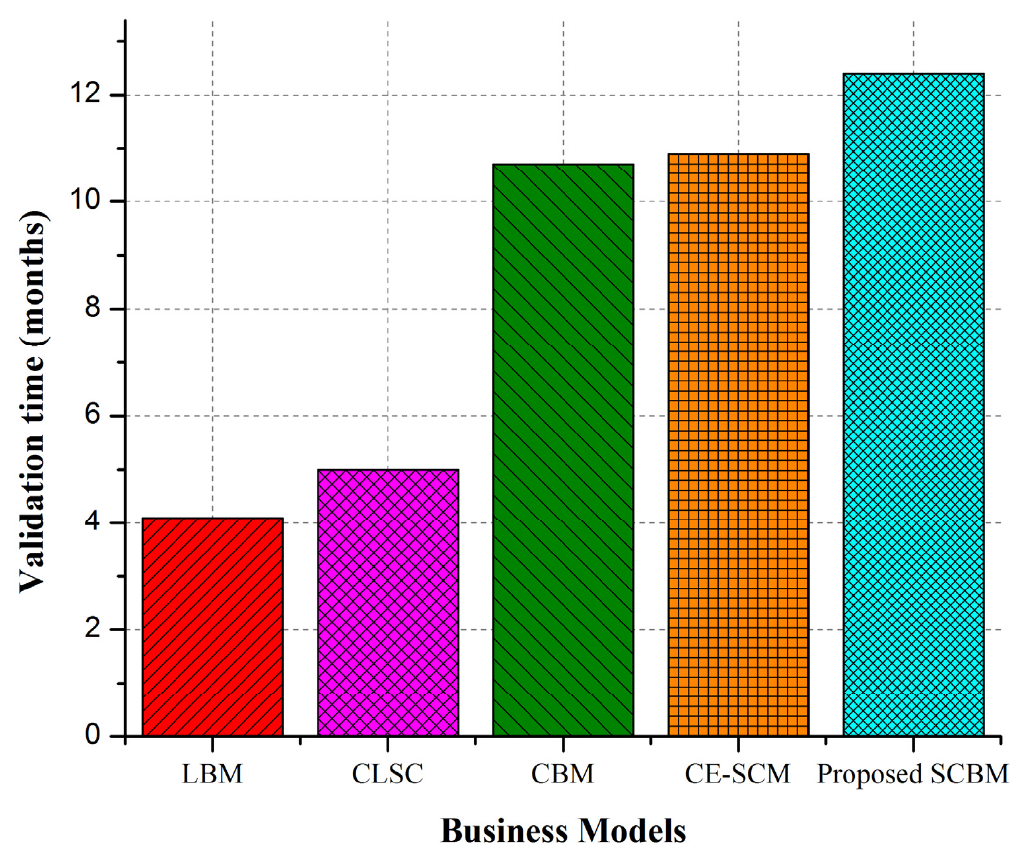
Figure 8. Validation time taken for various business models.